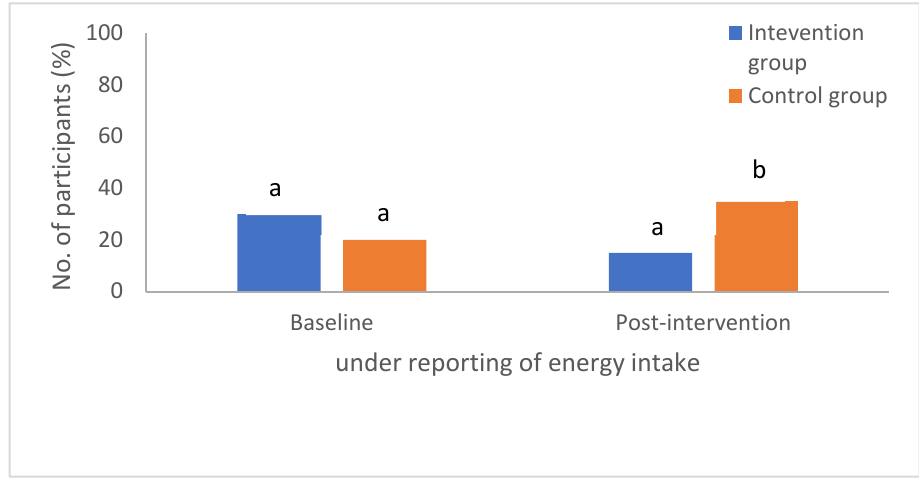
Figure 5. Number of participants under-reporting daily energy intake at post-intervention. Letters (a,b) indicate values are statistically significantly different ( p ≤ 0.05) at each time point.